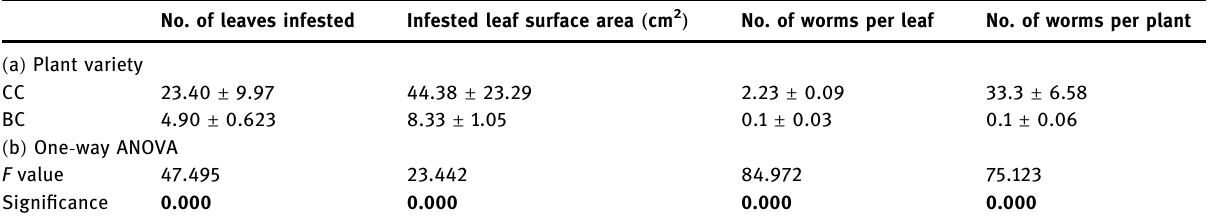
Table 4: ( a ) Mean values ± standard deviation on worm infestation. ( b ) Signi fi cance of infestation characteristics under one - way ANOVA analysis